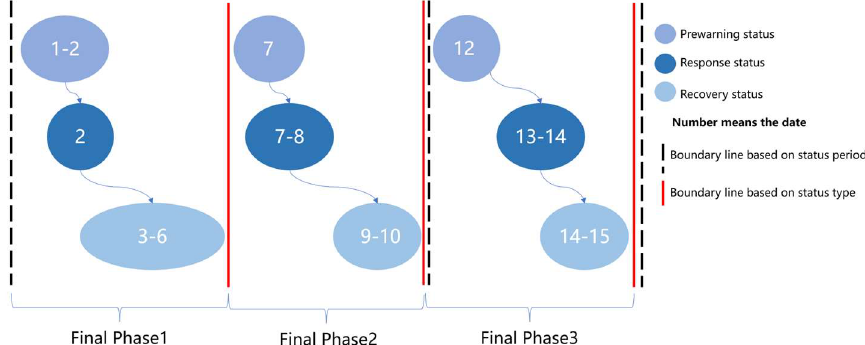
Figure 11. Schematic diagram of determining the scope of the final phase based on the status type (the number in the circle represents the time element and “1–2” means 1st day to 2nd day).